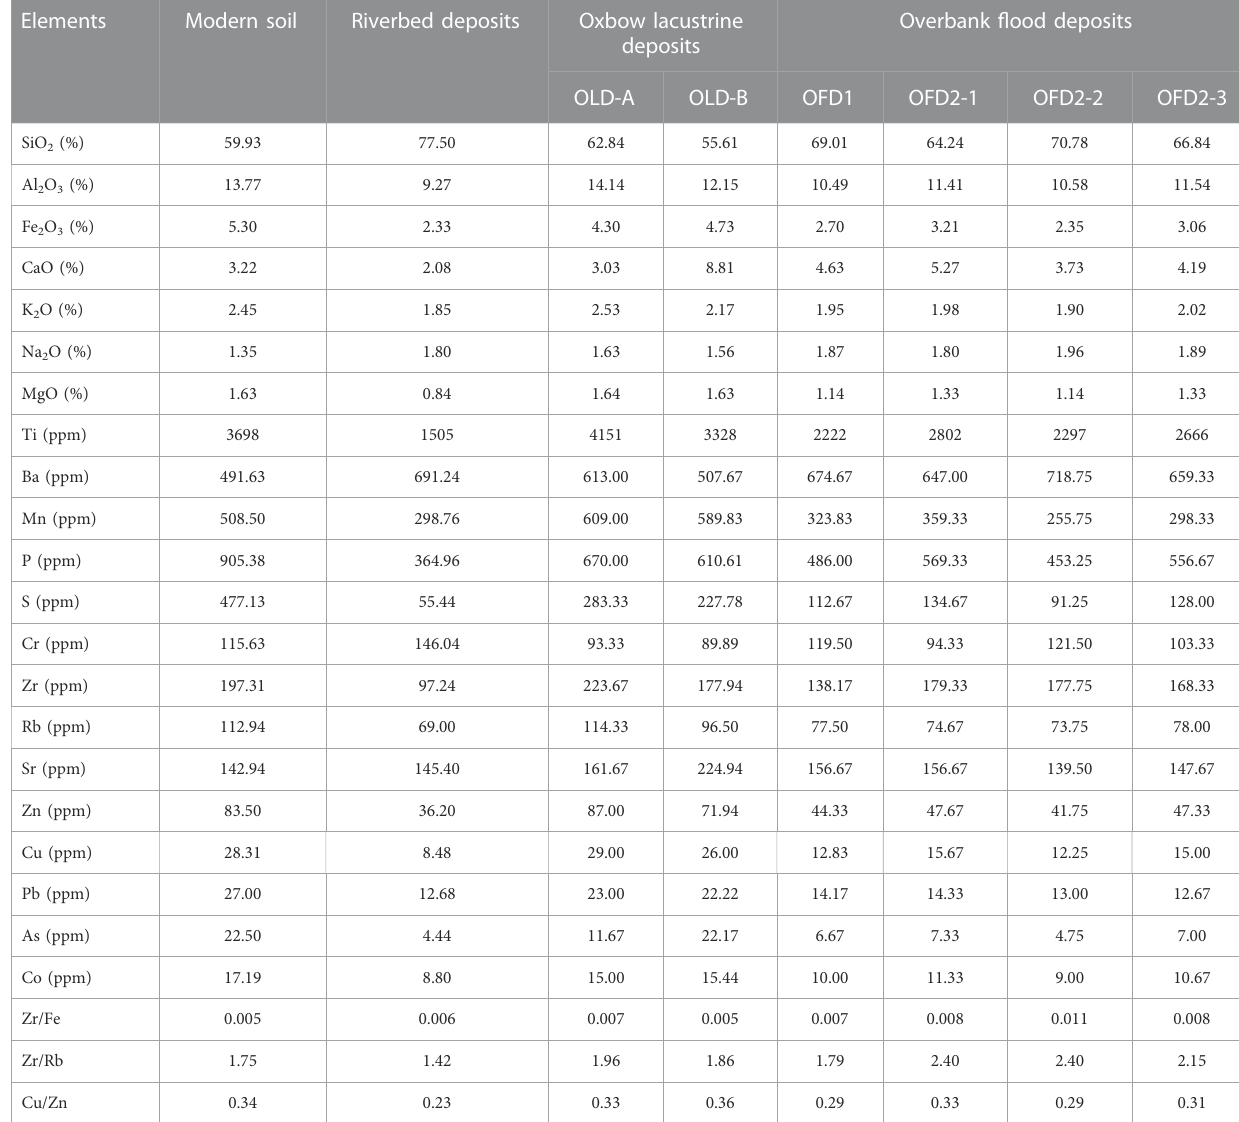
TABLE 2 Average content of major elements oxides, trace elements and element ratios of the paleo-oxbow lake fi ll at NYQ-B site within the Zoige Basin on the NE Tibetan Plateau.